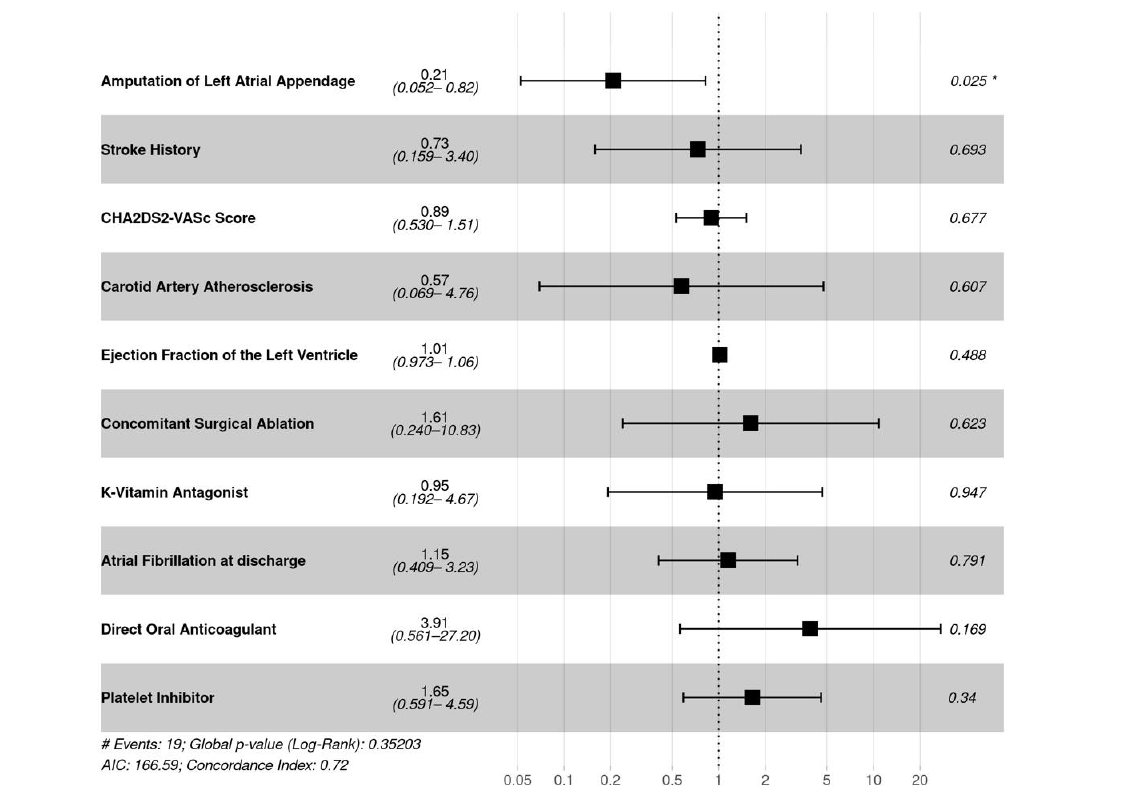
Figure 3. Analysis of the effect of potential covariates on ischemic stroke in matched patients with versus without left atrial appendage amputation. * significant hazard ratio.